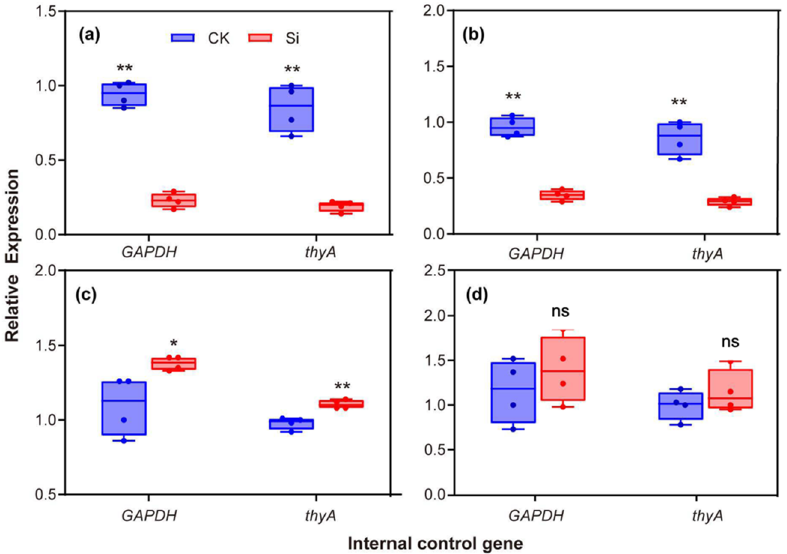
Figure 5. Effects of exogenous silicon on the relative expression of virulence-related genes of R. solanacearum. ( a ) xpsR (transcriptional regulator). ( b ) epsD (the genes coding for EPS). ( c ) pilE (the genes coding for twitching motility). ( d ) fimT (the genes coding for swimming motility). CK: non-Si treatment; Si: Si treatment. “ns” indicates not significant ( p > 0.05), * and ** indicate significant difference among treatments at p ≤ 0.05 and p ≤ 0.01 in t -test.